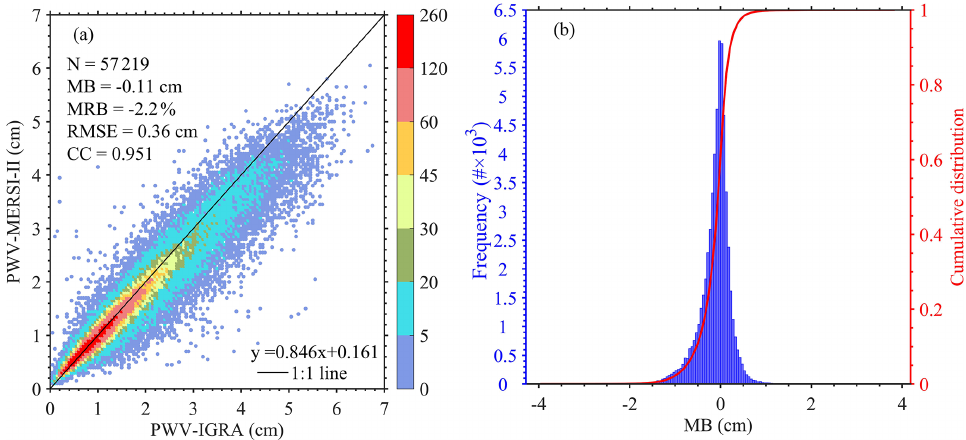
Figure 4. (a) Total density scatterplot of PWV derived from MERSI-II against that of IGRA for each bin of PWV in a 0.05cm × 0.05cm grid. The solid line represents the 1:1 line. (b) Frequency histogram of MB between MERSI-II and IGRA PWV superimposed on a cumulative distribution